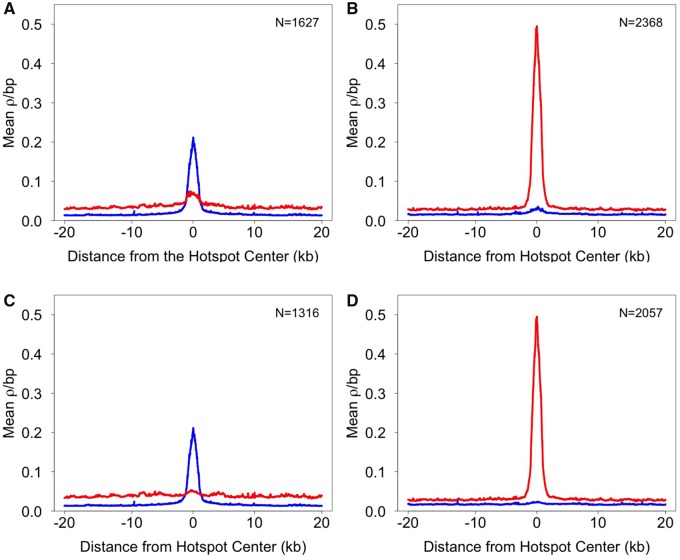
—LD-based recombination rates around hotspots are population-specific. Mean recombination rates are shown across a 40 kb interval, flanking the center of hotspots. (A) The mean recombination rate in shared and population-specific Lake Washington hotspots is higher in the Lake Washington population (blue) compared with the same loci in the Puget Sound population (red). (B) The mean recombination rate in shared and population-specific Puget Sound hotspots is higher in the Puget Sound population compared with the same loci in the Lake Washington population. (C and D) The pattern is more pronounced when shared hotspots are removed from the comparison, leaving only the population-specific hotspots.